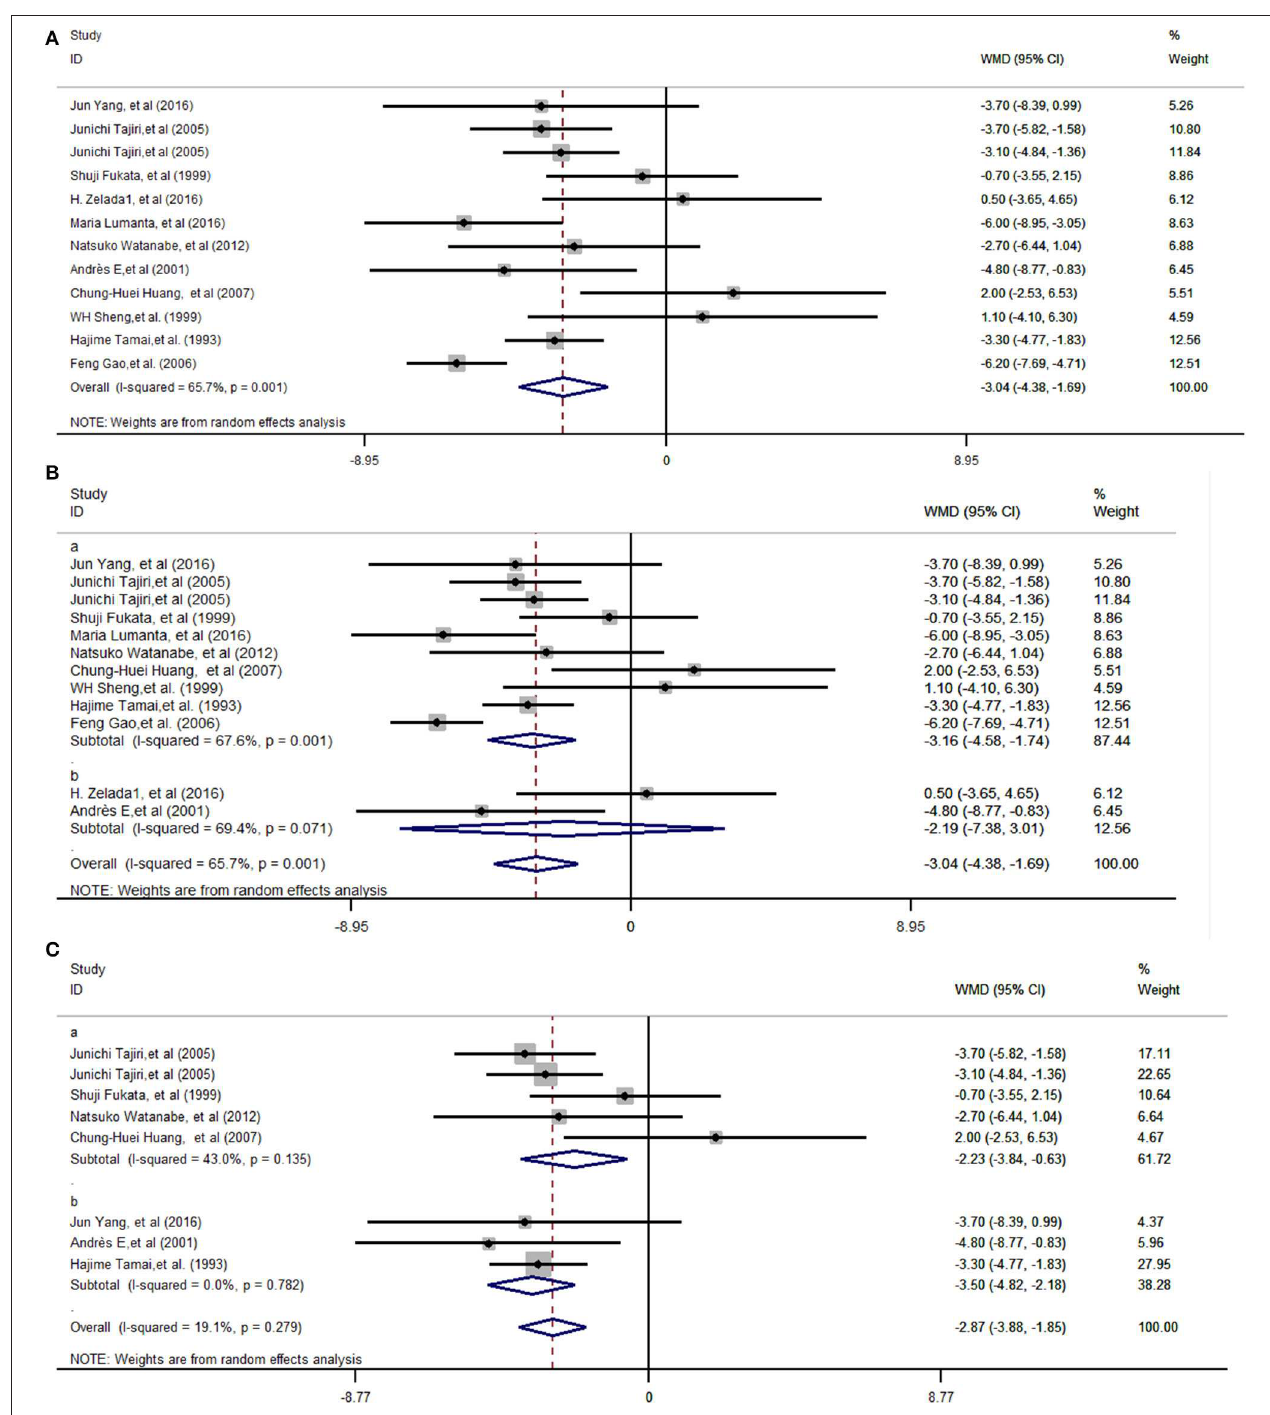
FIGURE 2 | Forest plots depicting the recovery duration for ATD-induced agranulocytosis between G-CSF and non-G-CSF groups. Diamonds indicate the overall summary estimate (width of the diamonds represents the 95% CI); boxes indicate the weight of individual studies in the pooled analysis; dots indicate the WMD of each study; bars indicate the 95% CI of each study. It shows an overall pooled WMD of − 3.04 days (95% CI = − 4.38 to − 1.69, P = 0.000) in the random-effects model, indicating that G-CSF can shorten the recovery duration of ATD-induced agranulocytosis (A) . The pooled effects in different regions, Asia (B a ) , and in South America and Europe (B b ) , were a WMD of − 3.16 days (95% CI: − 4.58 to − 1.74, P = 0.000) and a WMD of − 2.19 days (95% CI: − 7.38 to 3.01, P = 0.409), respectively. The subgroup effects with different recovery criteria showed that when the granulocyte count was more than 0.5 × 10 9 /L (C a ) , the WMD was − 2.23 (95% CI: − 3.84 to − 0.63, P = 0.006), and when the criteria was a granulocyte count of more than 1.0 × 10 9 /L or 1.5 × 10 9 /L (C b ) , the WMD was − 3.50 days (95% CI: − 4.82 to − 2.18, P = 0.000). CI, Confidence interval; WMD, weighted mean difference.